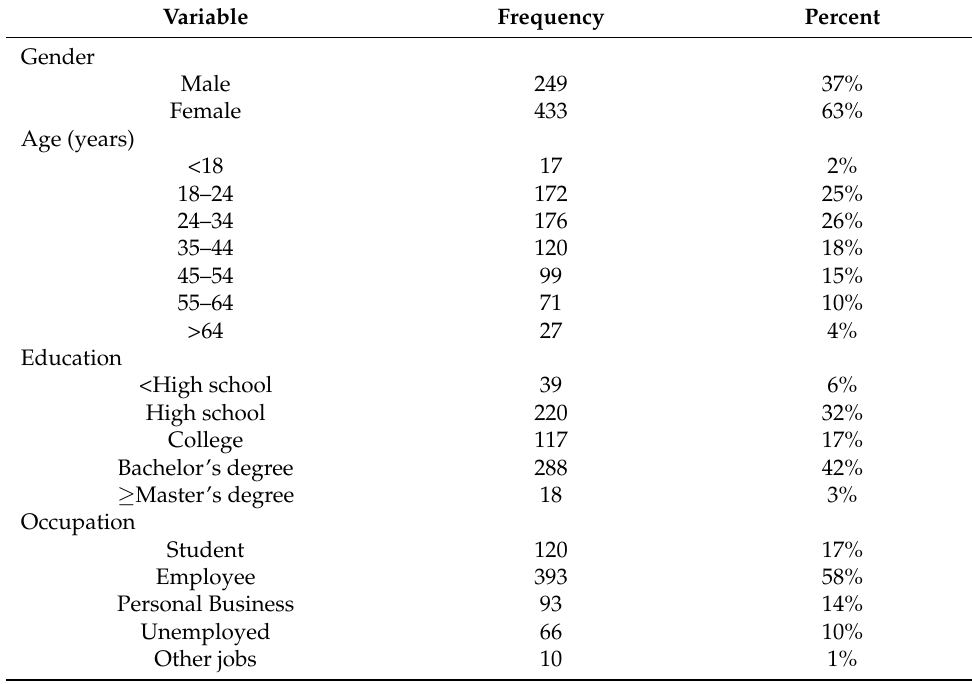
Figure 2. Map of the focus study area by buffer zones at 400 and 1000 m. Table 1. Demographic characteristics of